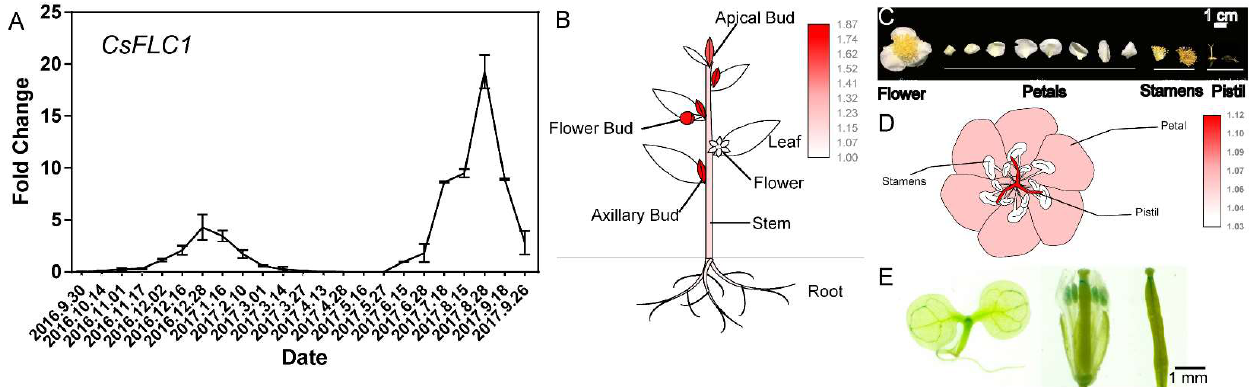
Figure 3. Expression patterns of CsFLC1 . ( A ) Expression of CsFLC1 in axillary or flower buds of tea plant throughout the year. ( B ) Different tissue expression of CsFLC in tea plant. ( C ) Various parts of flowers of tea plant. ( D ) Expression patterns of CsFLC1 in different parts of flowers in tea plant. ( E ) GUS staining of pCsFLC1::GUS transgenic Arabidopsis thaliana .